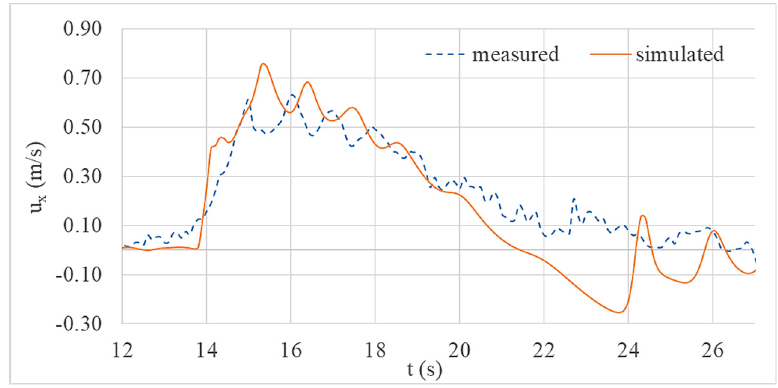
Figure 8. Comparison of current velocity (x-component) at location C.